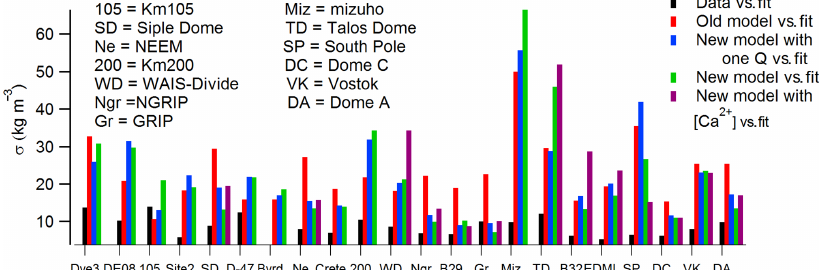
Figure 5. Representation of the σ fit-data in black and the σ model-fit (in red for the old model, in blue for the model with the new parameteri- zation except the three activation energies, in green for the new model with three activation energy, and in purple for the new model with the impurity effect) at 22 Greenland and Antarctic sites. The site characteristics are provided in Table